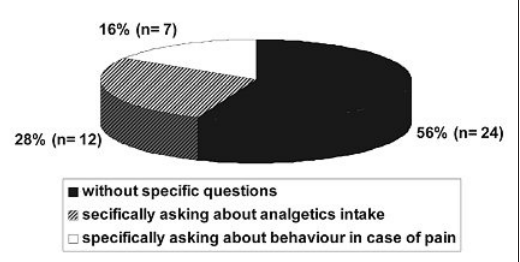
Impact of a specific medication history on NSAID intake